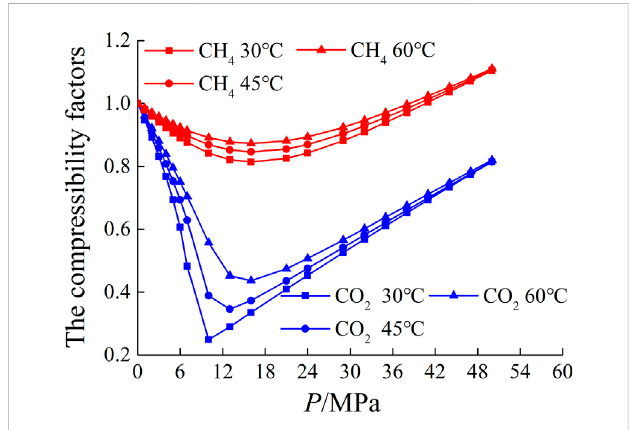
The compressibility factor of CH 4 and CO 2